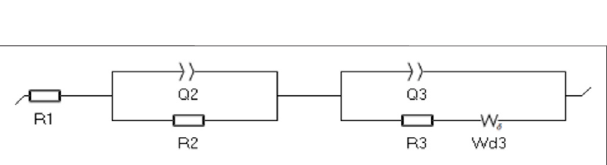
FIGURE 2 | ECM for both the anode and the cathode half